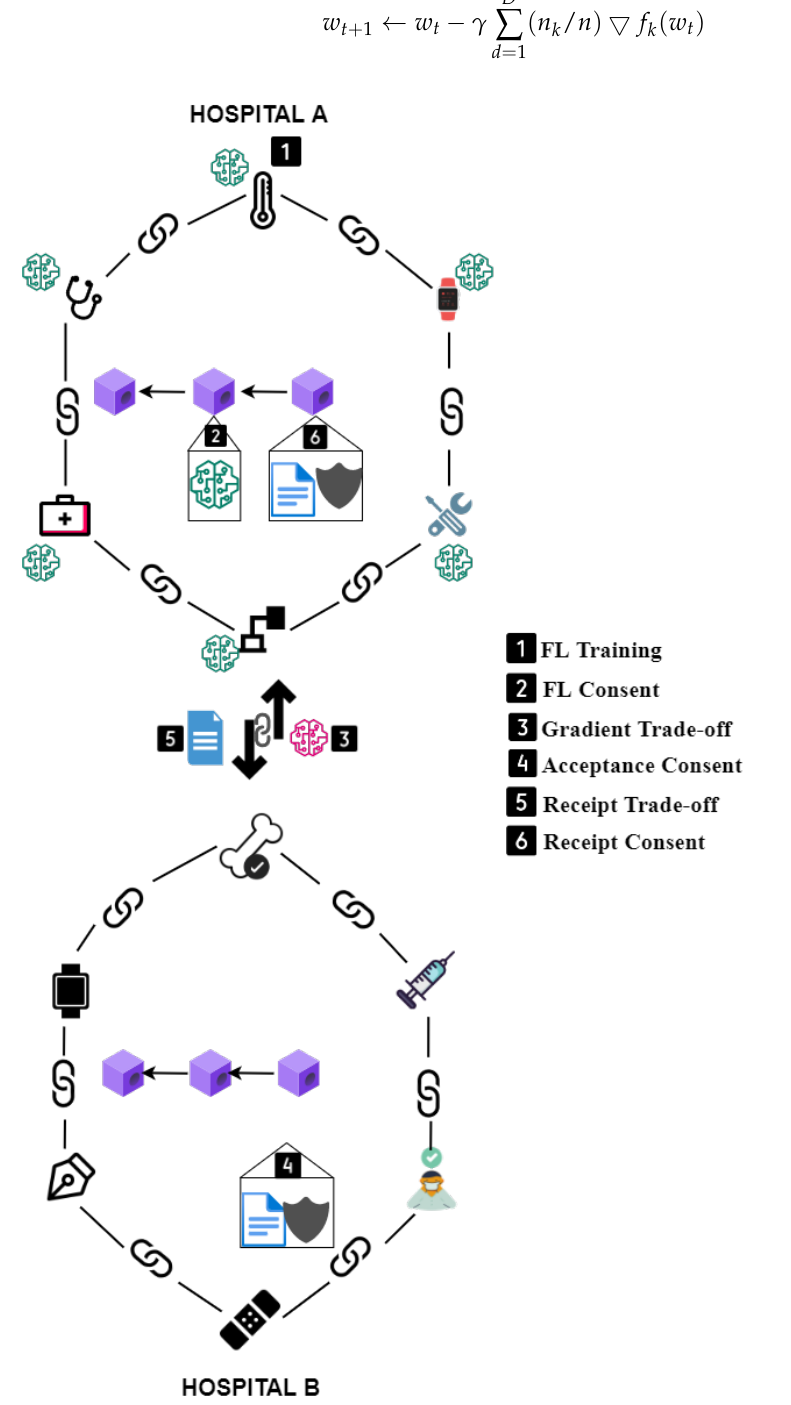
Figure 7. Gradient aggregation for the cross-cluster architecture